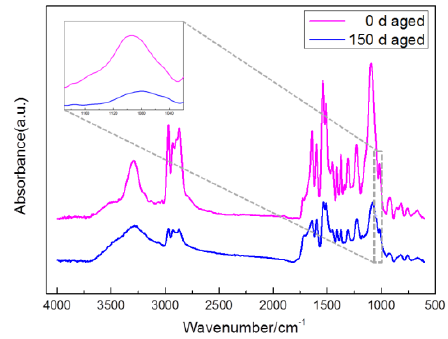
− 1 for unaged and aged